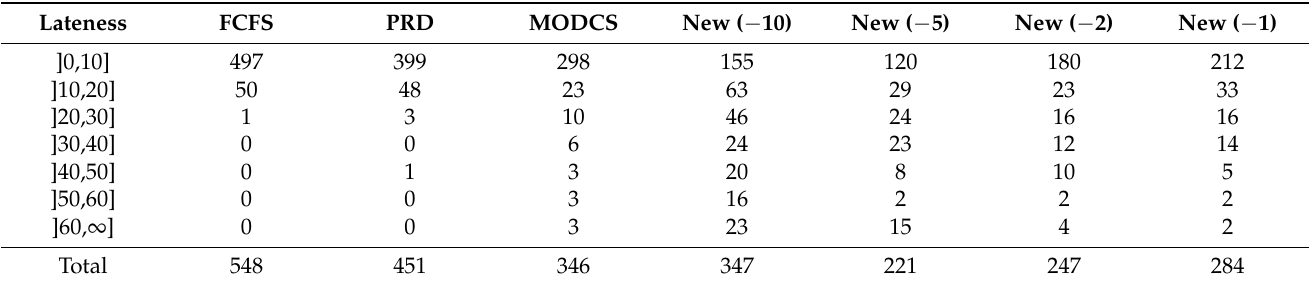
Table 5. Distribution of the number of tardy jobs for a workload norm of 4 time